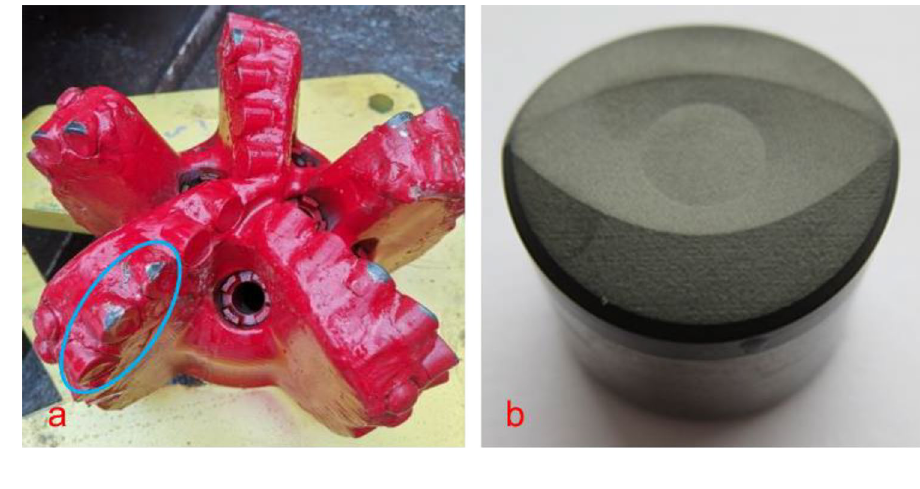
Fig. 23 Photographs of the 3D concave-shaped cutter PDC bit after run the well